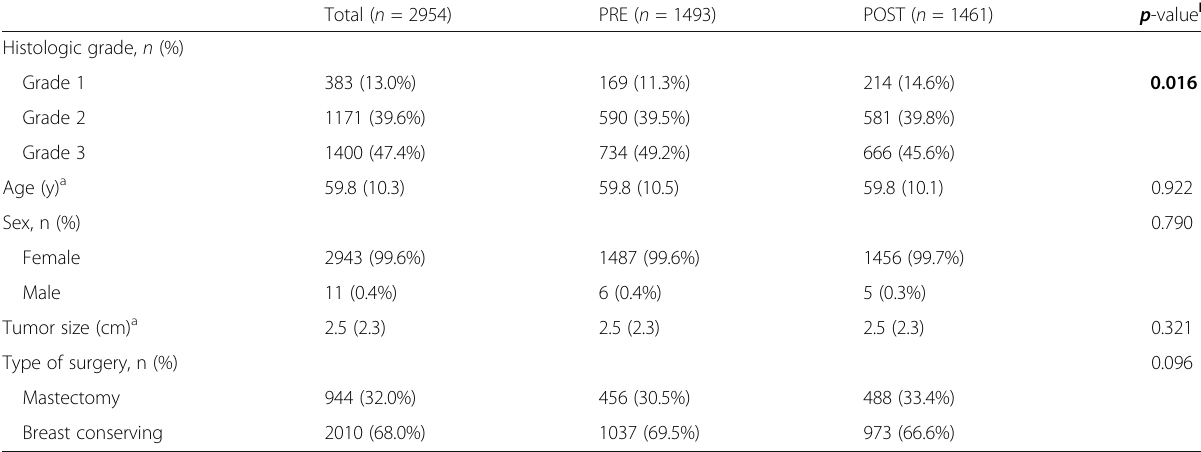
Table 1 Characteristics of the 2954 included ductal carcinoma in situ (DCIS) lesions from the PALGA database between